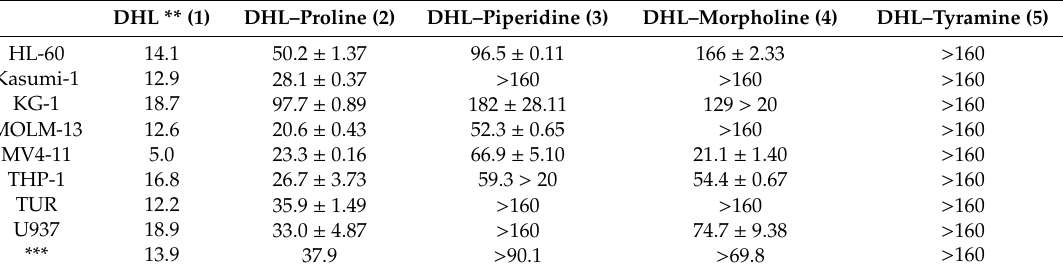
Table 2. Cytotoxic e ff ects of compounds 1 – 5 , expressed as EC 50 ( ± SD) values *. DHL **